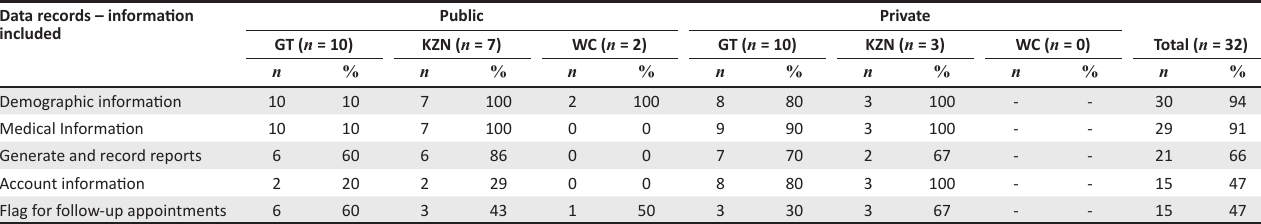
TABLE 1: Information included in EHDI data management systems. Data records – information included